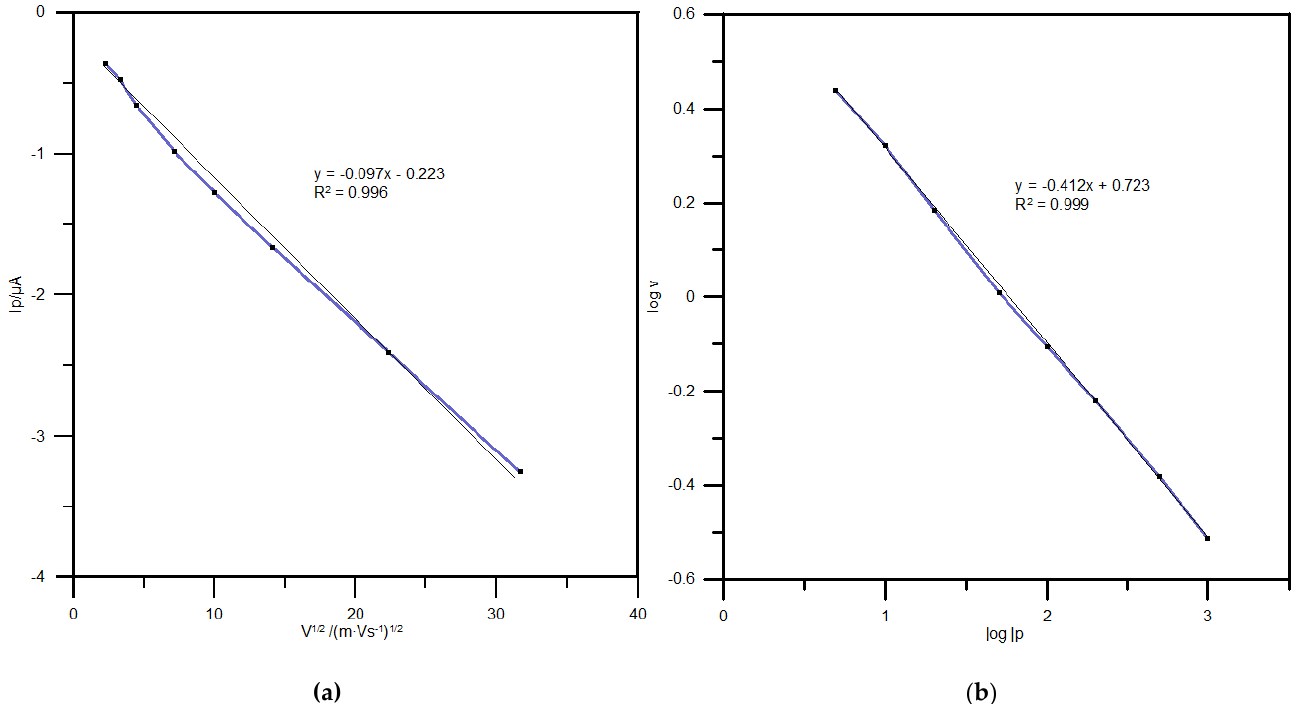
Figure 5. ( a ) Dependence of the cathodic peak current for the reduction of In(III) + 1 × 10 −4 mol · dm −3 acetazolamide ( I p ) on the square root of the scan rate ( v 1/2 ). ( b ) The log-log dependence of the reduction peak current and the scan rate over the interval from 5 to 1000 mVs −1 . Each point is the average of three measurements.